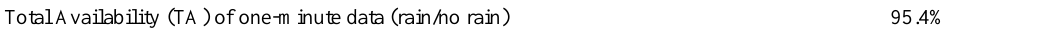
Table 1. Summary of the available data included in the Field Intercomparison dataset.